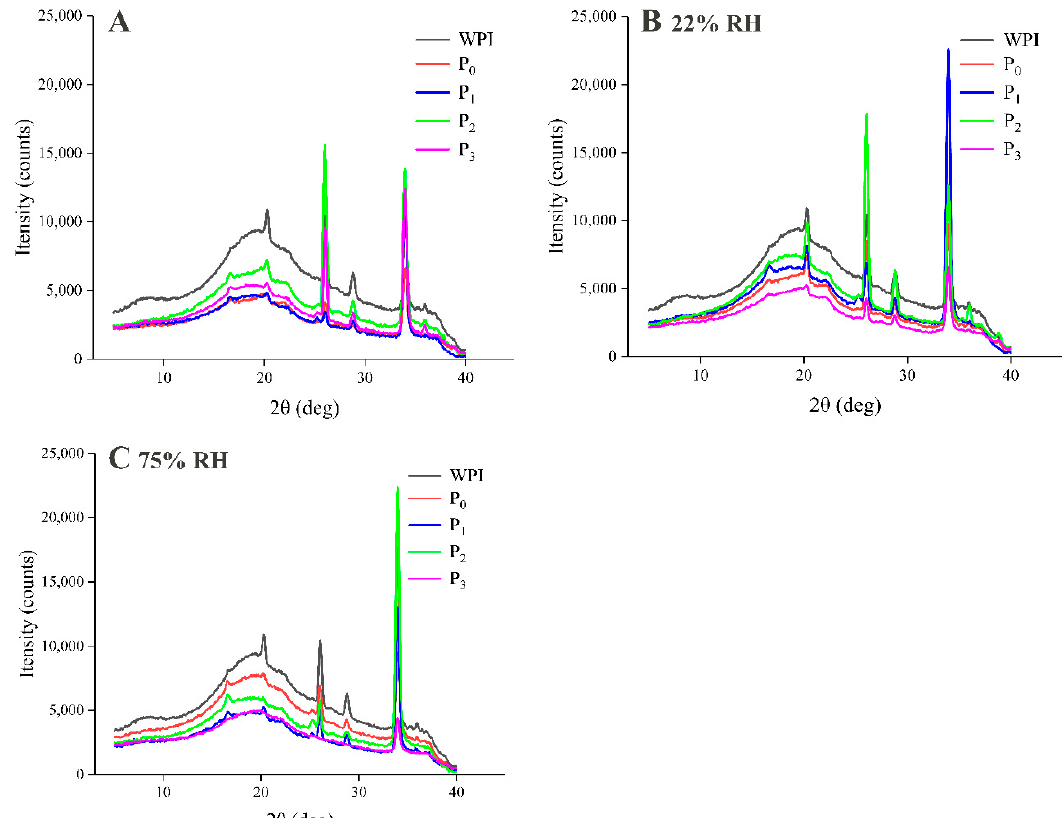
Figure 6. X-ray di ff raction of WPI and powdered microcapsules before storage ( A ) and at relative Figure 6. X-ray diffraction of WPI and powdered microcapsules before storage ( A ) and at relative humidity (RH) 22% ( B ), 75% ( C ) during storage of storage for 12 humidity (RH) 22% ( B ), 75% ( C ) during storage of storage for 12 h.